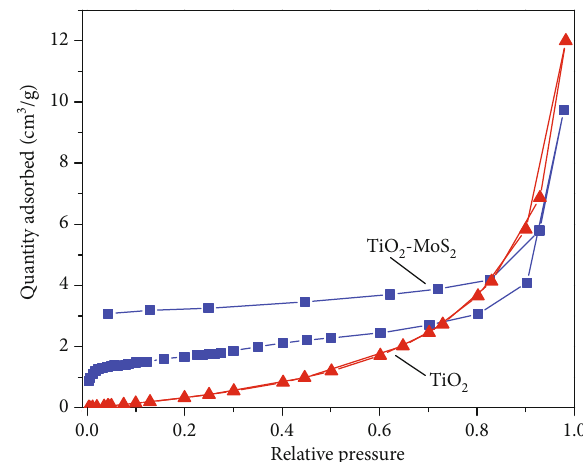
nano fi bers and TiO 2